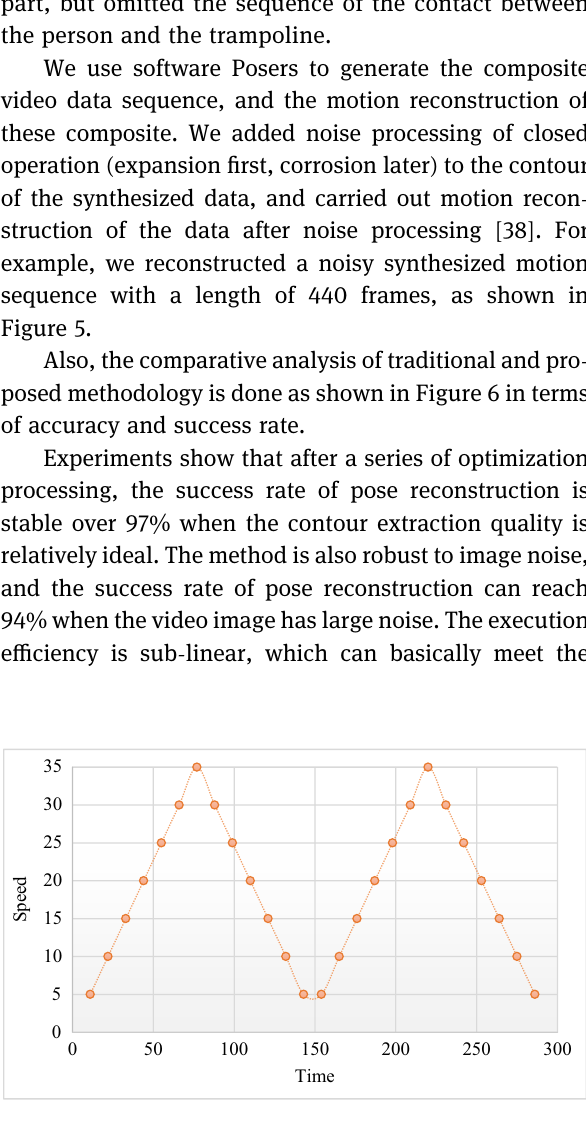
Figure 5: Comparison of Y velocity component of root position between reconstructed results and real data.